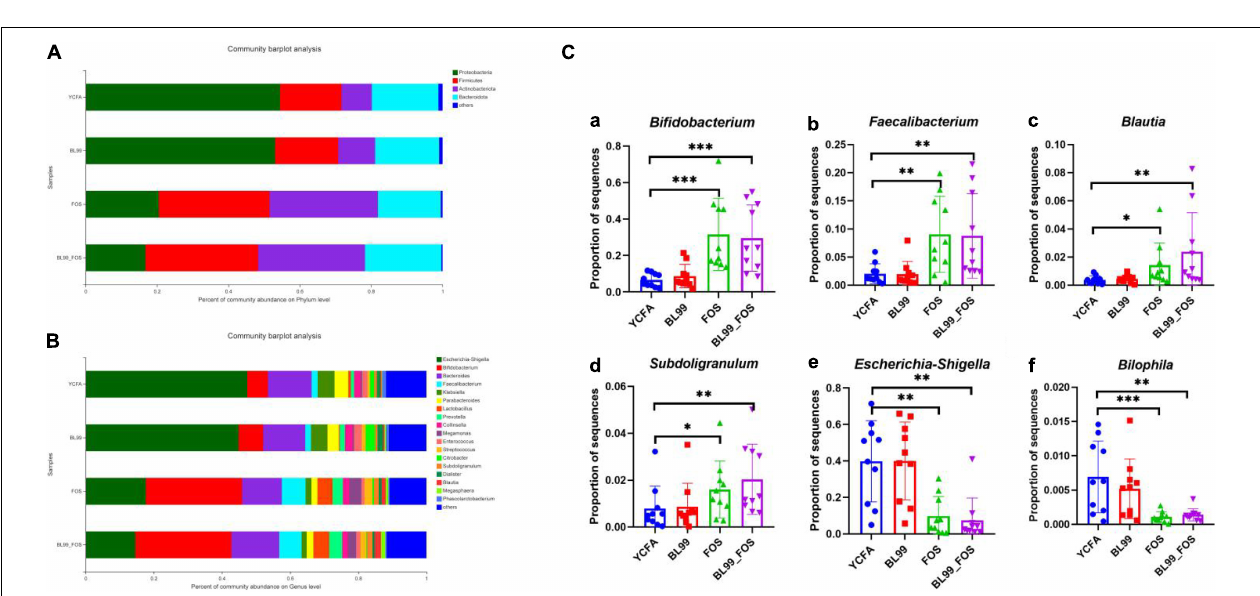
FIGURE 3 | PCoA plots for α -diversity indices in different groups, including the Simpson index (A) , Shannon index (B) , Chao index (C) , Sobs index (D) , and Ace index (E) , and β -diversity analysis (F) .